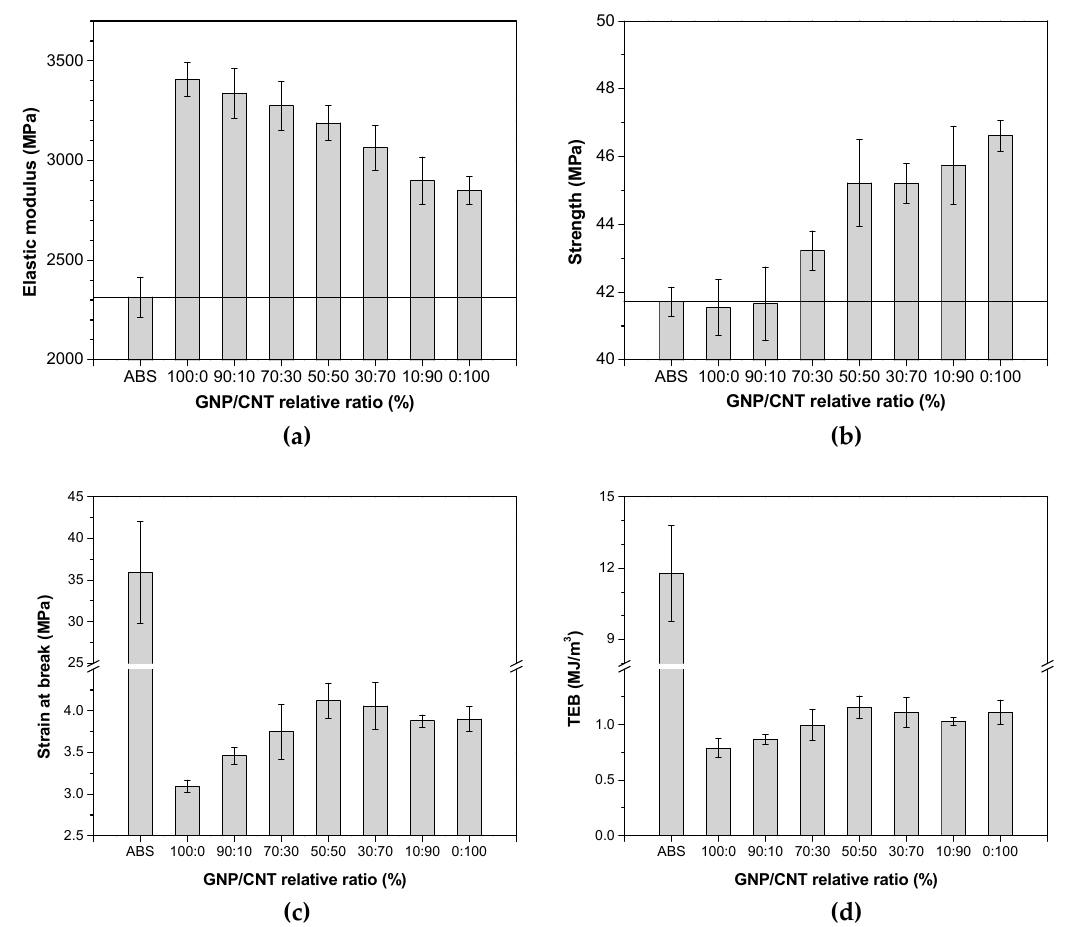
Figure 4. Tensile properties of ABS and various GNP / CNT hybrid nanocomposites with a total nanofiller amount of 6 wt.% produced by compression molding: ( a ) elastic modulus, ( b ) strength, ( c ) strain at break, and ( d ) tensile energy to break (TEB). Representative stress–strain curves are shown in Figure S1a (Supplementary Materials).